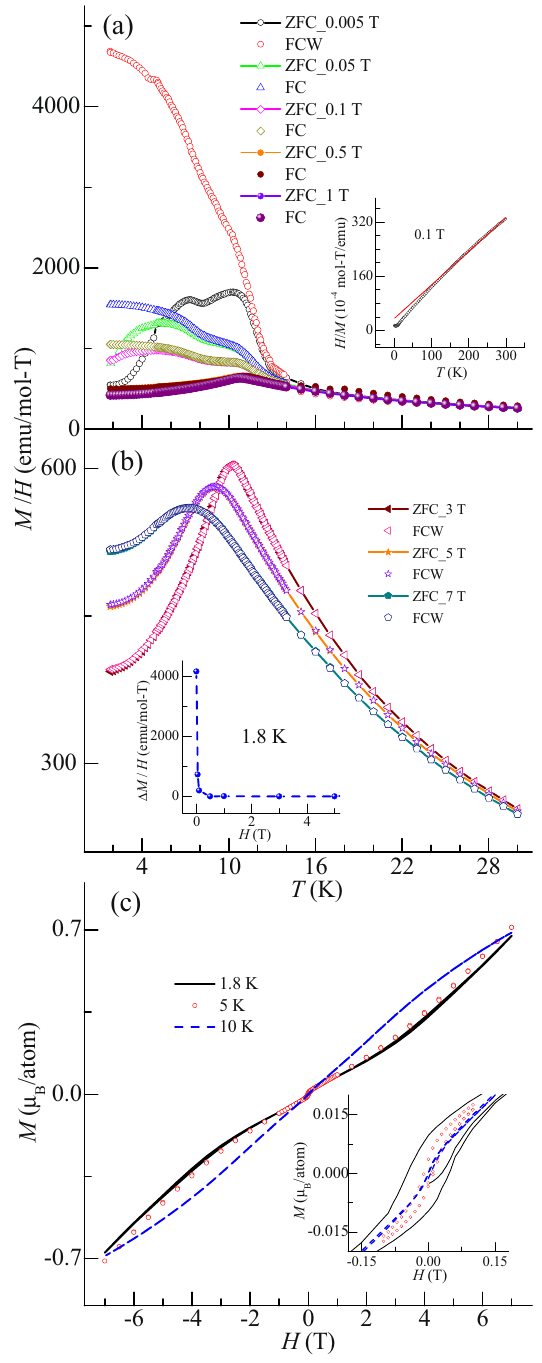
Figure 2. ( a , b ) Temperature ( T ) dependent DC susceptibility ( M / H ) in field range of 0.005–7 T under ZFC and FCW condition. Inset ( a ): Temperature dependent H/M at 0.1 T. Red curve shows the Curie Weiss law fitting. Inset ( b ): Magnetic field ( H ) dependent Δ M / H ( Δ M = M FC − M ZFC ) at 1.8 K. ( c ) Isothermal magnetization ( M ) curves as a function of magnetic field (7 to − 7 T) at 1.8, 5 and 10 K. Inset: Expanded form of the same curves at low